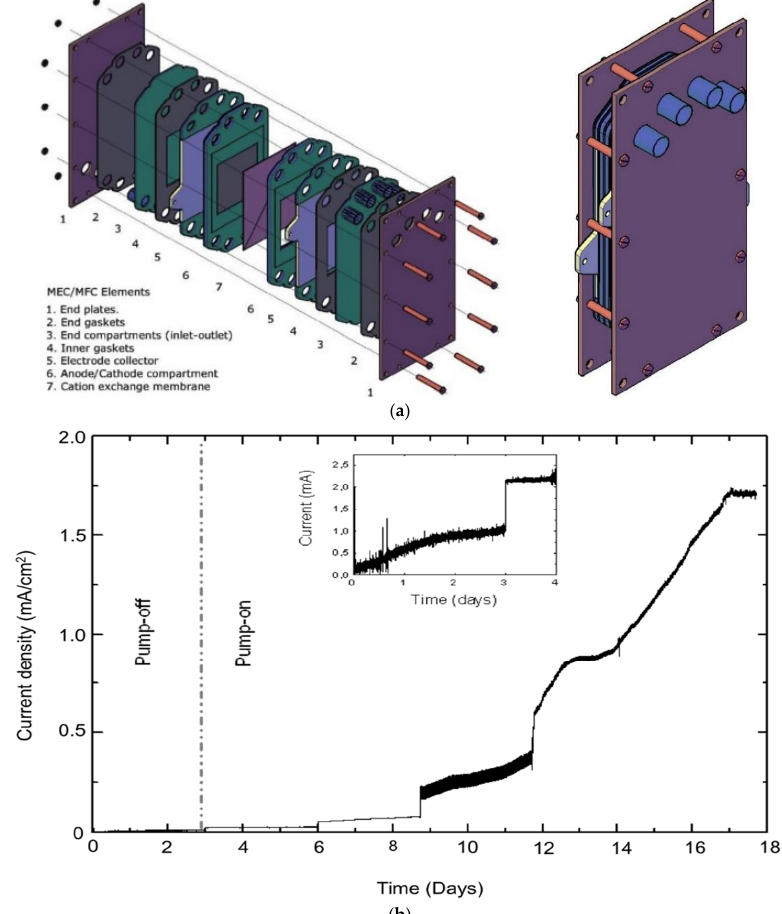
Figure 1. ( a ) Schematic of the filter press ‐ based bioelectrochemical reactor used for microbial electrolysis cell (MEC) and microbial fuel cell (MFC) operations; ( b ) electric current production for starting ‐ up the MEC after inoculation with batch ‐ grown cells. Monitoring of current density revealed sudden increases at days 6, 9 and 12. They were due to the replacement the media. Pump ‐ off: peristaltic pump off; Pump ‐ on: peristaltic pump on. Inset: zoom of the electric current production during the first 4 days after inoculation.